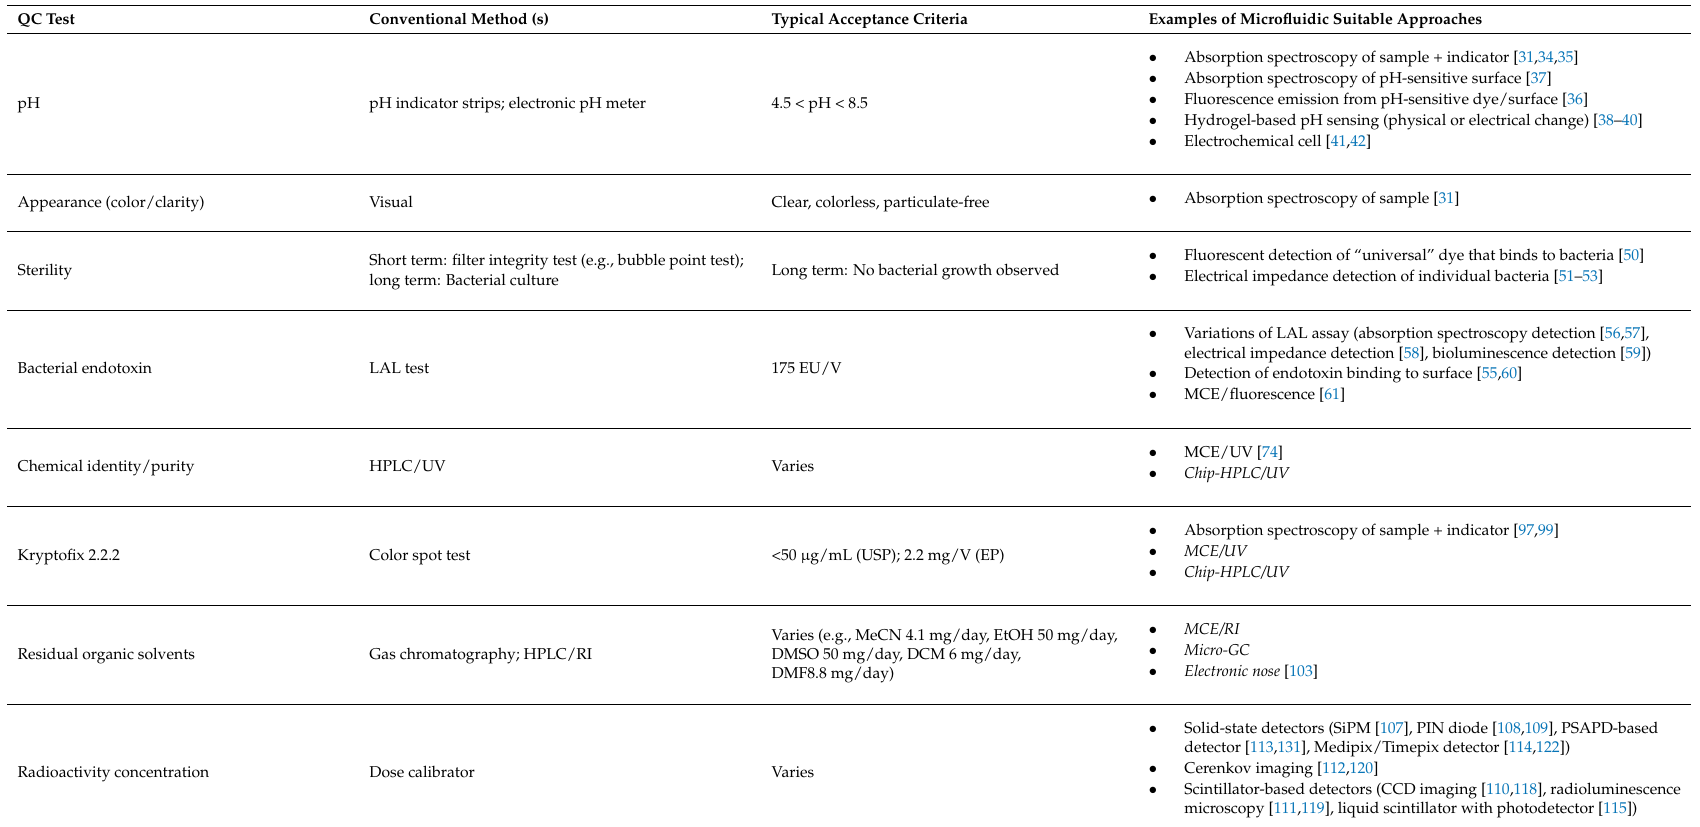
Table 1. Summary of required QC tests, the conventional method(s) used, and typical specifications. In addition, examples of microfluidic approaches to perform each test are listed. Note we have indicated in italics approaches that have not been demonstrated/proven, but may be possible in principle. Abbreviations: HPLC/UV = HPLC with UV absorbance detector, HPLC/RI = HPLC with refractive index detector,